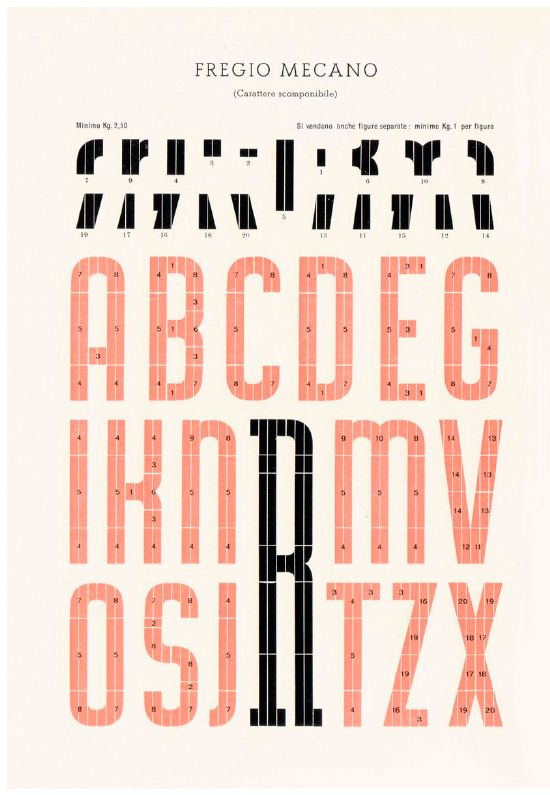
Figure 6. Fregio Mecano. Nebiolo catalogue, ca.